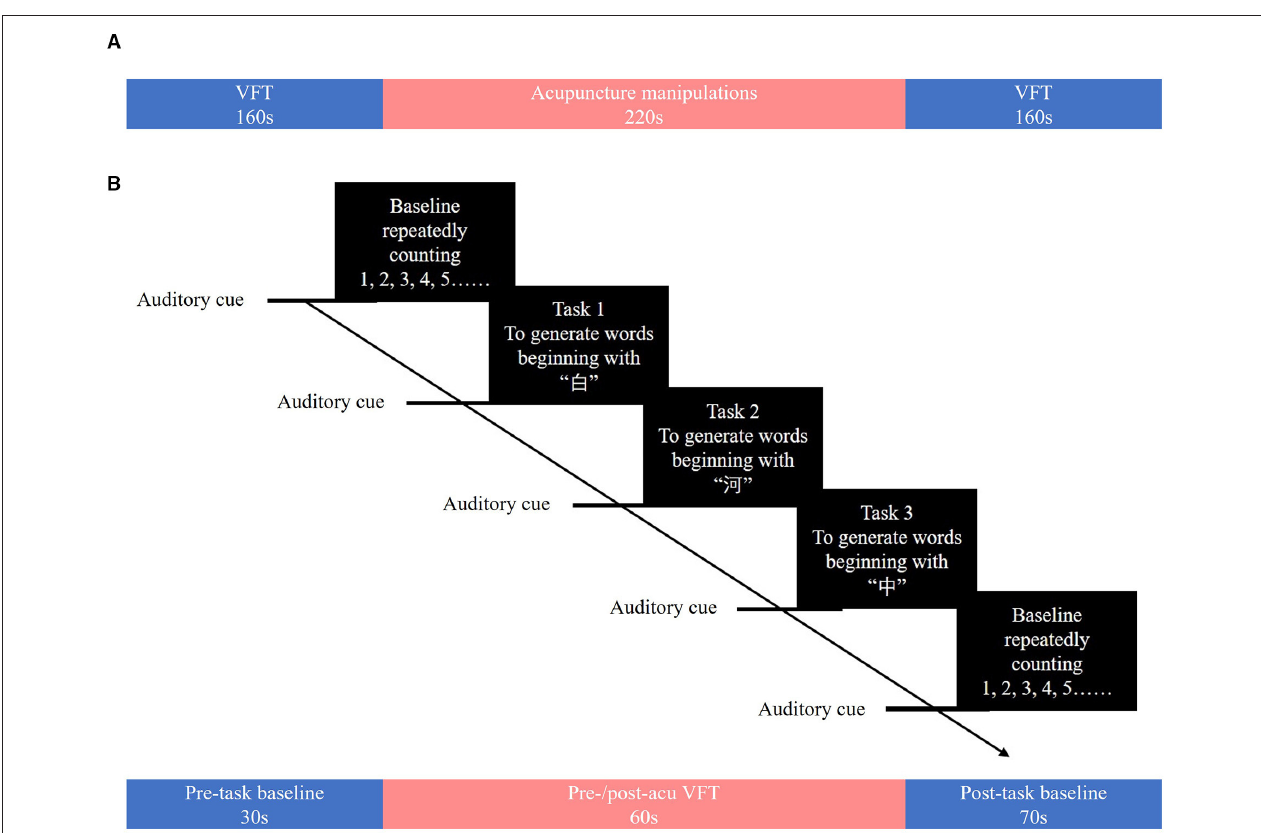
FIGURE 1 | (A) Overview of the study. (B) The verbal fluency task. The verbal fluency task consisted of a 30-s pre-task resting-state period and three 20-s word-generating tasks followed by a 70-s post-task resting-state period.